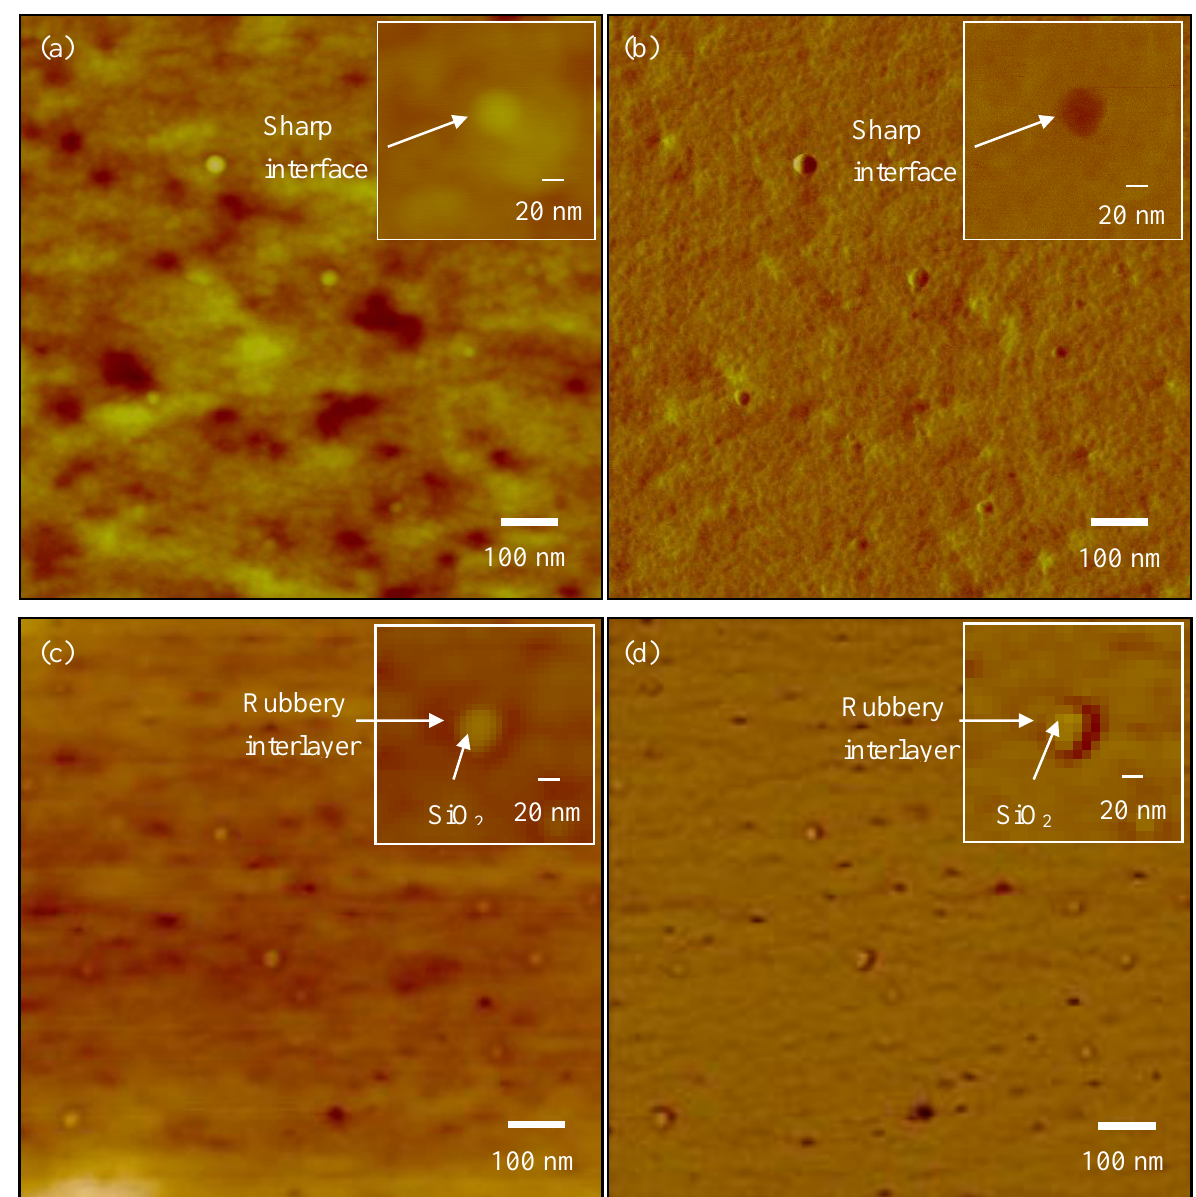
Figure 3. ( a ) AFM height image of 0.3 vol% PGMA-SiO 0.3 vol% PGMA-SiO /epoxy; ( c ) AFM height image of 0.3 vol% 20k20k-SiO 2